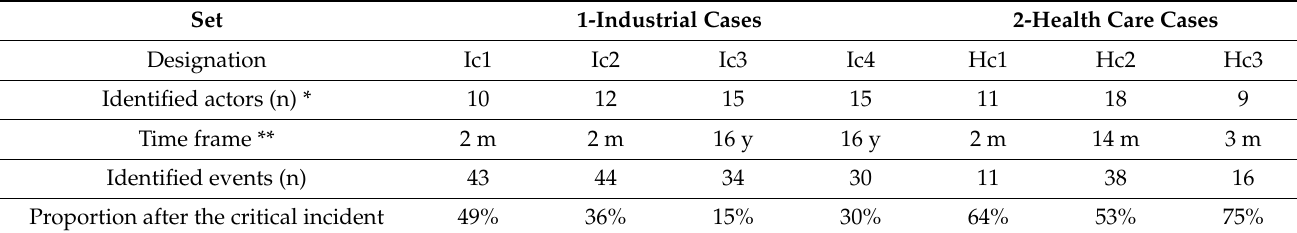
Table 3. Overview of event investigations with the combined method approach